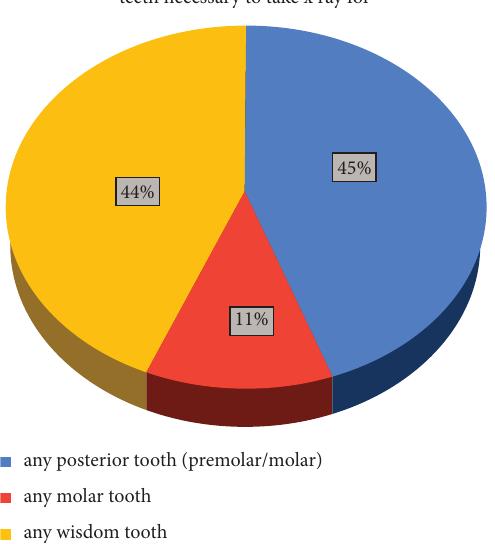
Figure 4: Teeth necessary to take X-ray for.